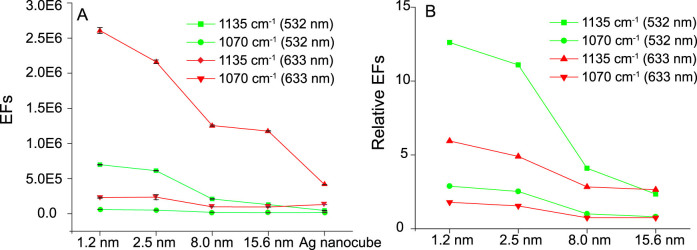
(A) EFs of Ag nanocubes and double-shelled Au/Ag nanoboxes; and (B) relative EFs (i.e., EFdouble-shelled nanobox/EFAg nanocube) for peaks at 1135 and 1070 cm−1.